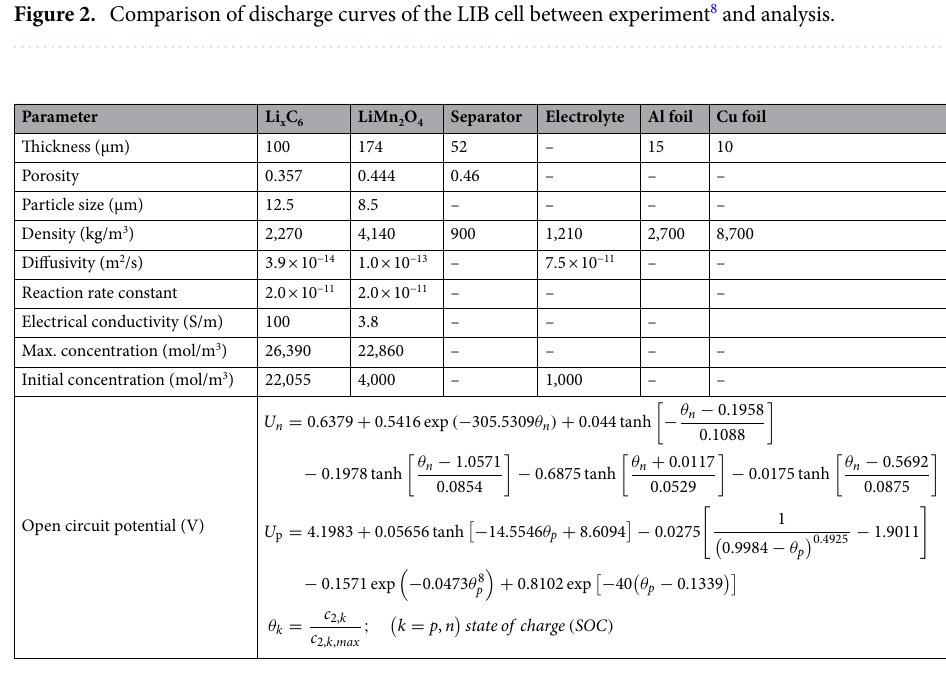
Table 1. Material properties and dimensions of the LIB cell 8,26